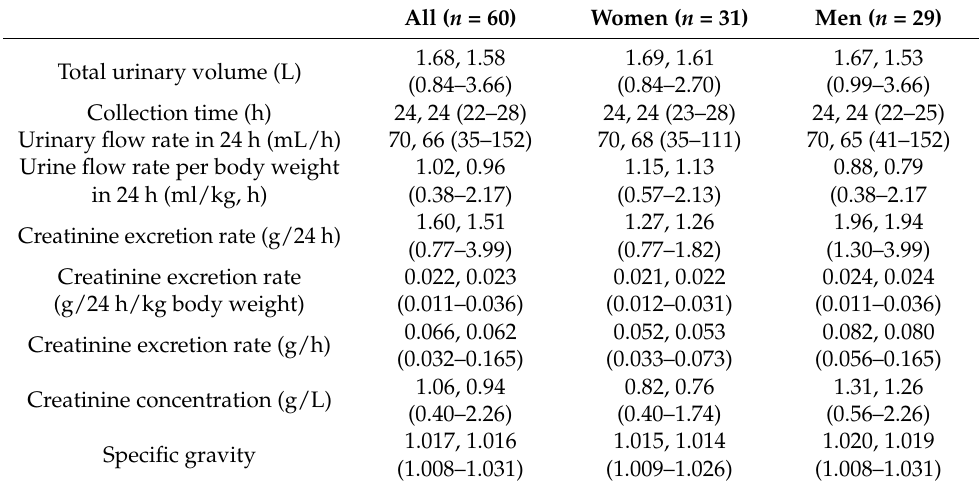
Table 2. Urinary excretion in 24 h for 60 subjects participating in the variability biobank. Mean, median and (range) of individual two-day means (one subject has missing data for one day) are given.